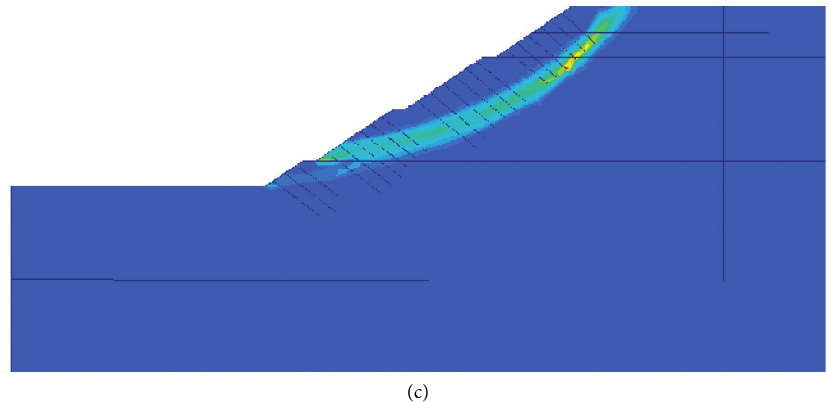
Figure 8: Shear strain increment nephogram of the slope after strength reduction. (a) Working condition 4. (b) Working condition 6. (c) Working condition 8.